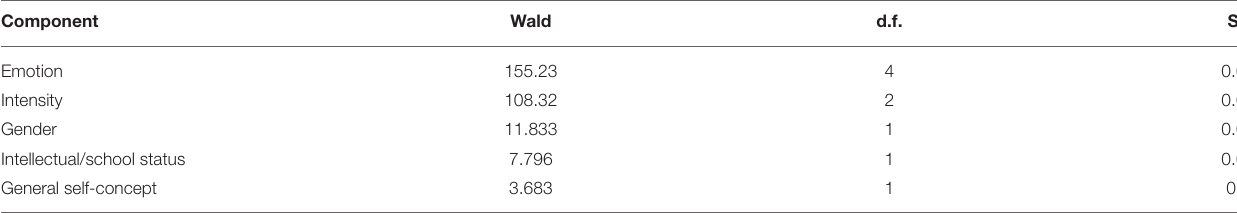
TABLE 1 | Components of the binomial logistic regression test and their contribution.